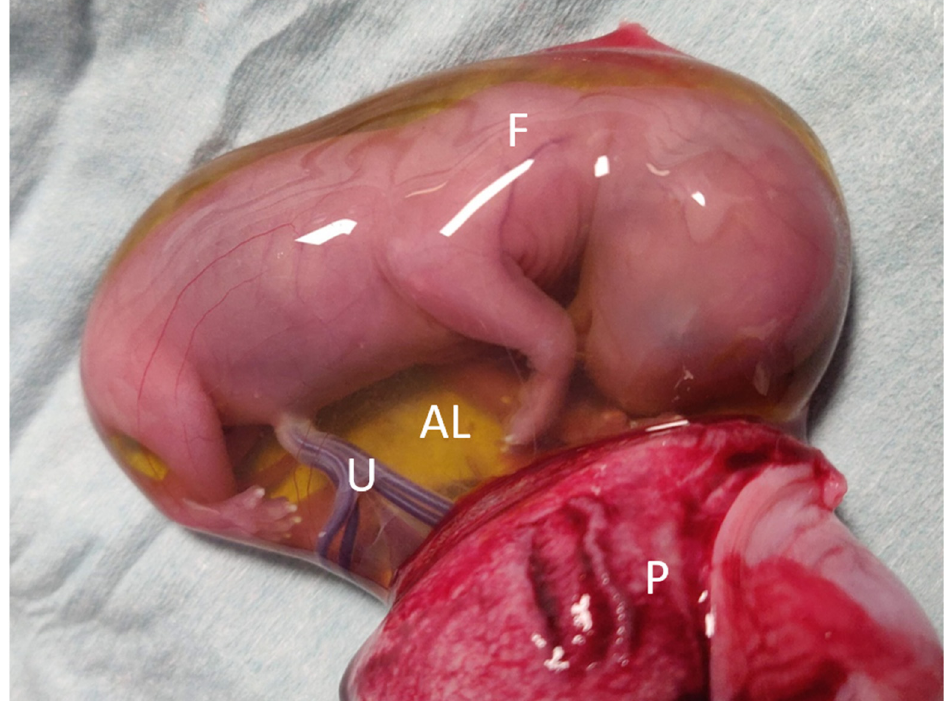
Figure 4. Excision of an embryonic vesicle. Visualization of the allantoic sac. Placenta (marked with “P”) has been carefully dissected from the rest of the vesicle. Allantoic sac (“AL”) is filled with a yellow fluid and contains the fetus (“F”). The umbilical cord is recognizable and is marked with “U”.